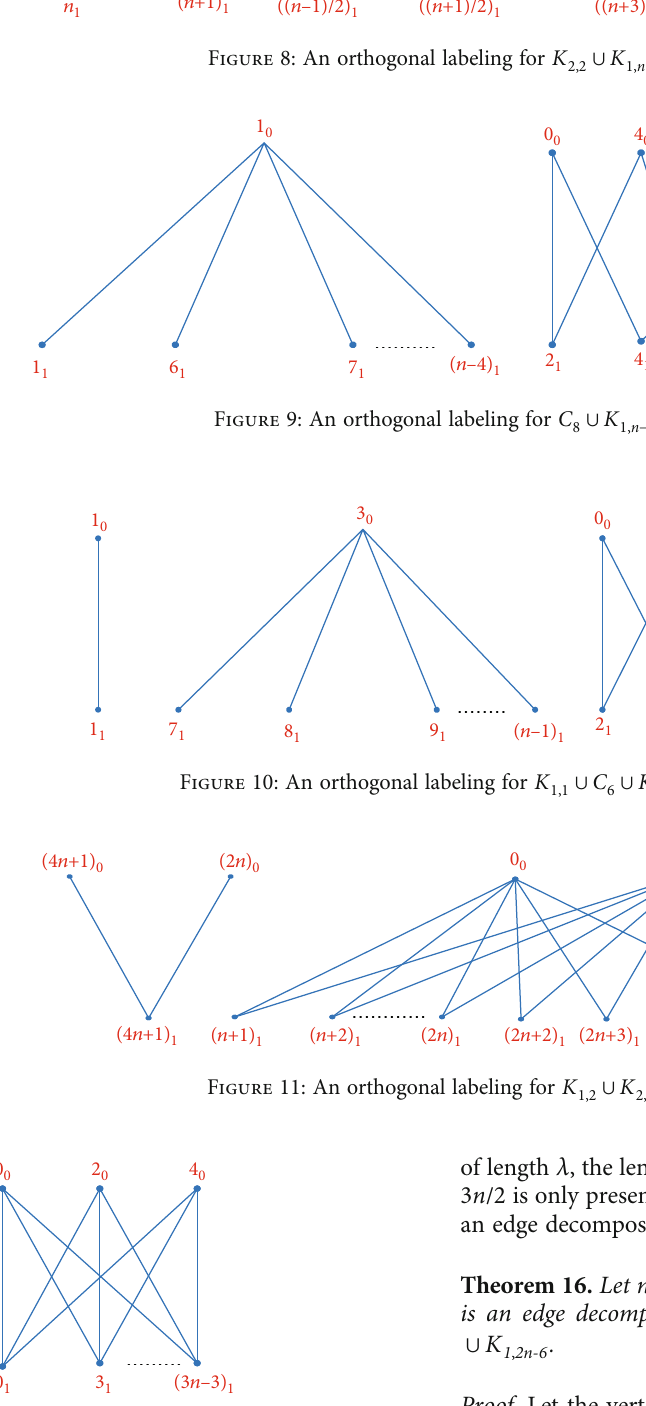
Figure 12: An orthogonal labeling for K